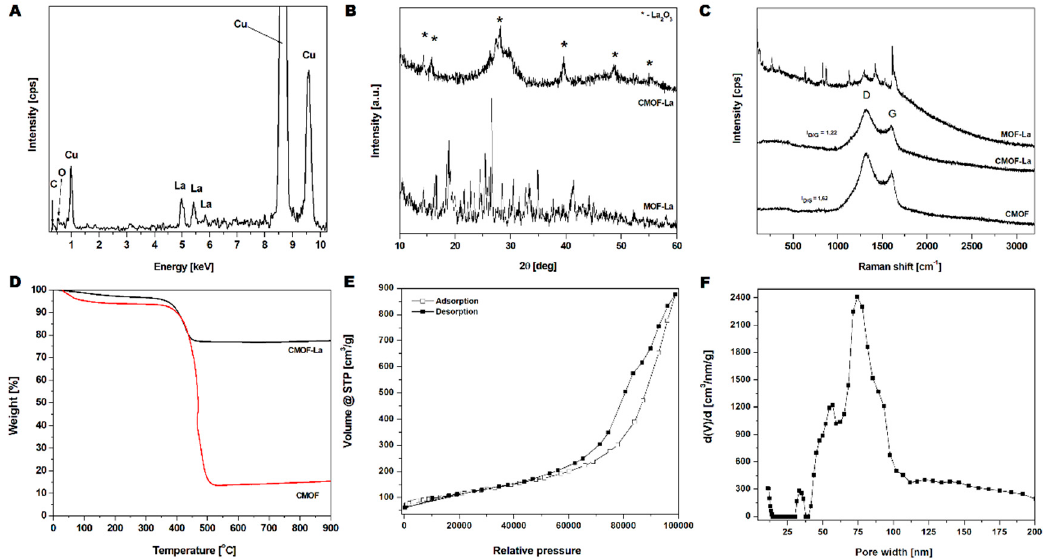
Figure 4. EDS spectrum of the carbonized lanthanum-based MOF ( A ); XRD ( B ) and Raman ( C ) spectra of MOF–La, CMOF–La and CMOF; TGA analysis of CMOF–La and CMOF ( D ); N 2 adsorption/desorption isotherms ( E ) and pore-width distribution ( F ) of CMOF.